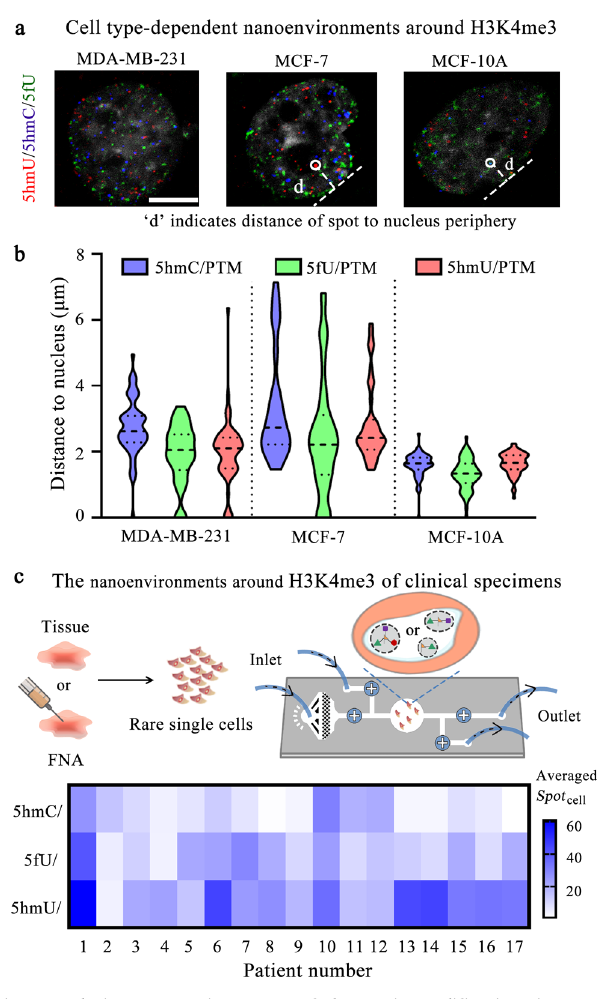
Fig. 6 Exploring nanoenvironments of chromatin modi fi cations in cancer samples. a Selected merged cell images for three breast cell lines. The letter “ d ” indicates the distance of the spot to nucleus periphery. The scale bar is 5 μ m. b Statistical analysis of the distances of spot to the nucleus periphery. The cell numbers are each 52, 44, and 64. c The detection of clinical tissues (No. 1 – 14) and FNA samples (No. 15 – 17) with a micro fl uidic chip. Upper panel, the schematic illustration of the work fl ow; bottom panel, heat map showing the averaged single-cell spot counts of three combinational chromatin modi